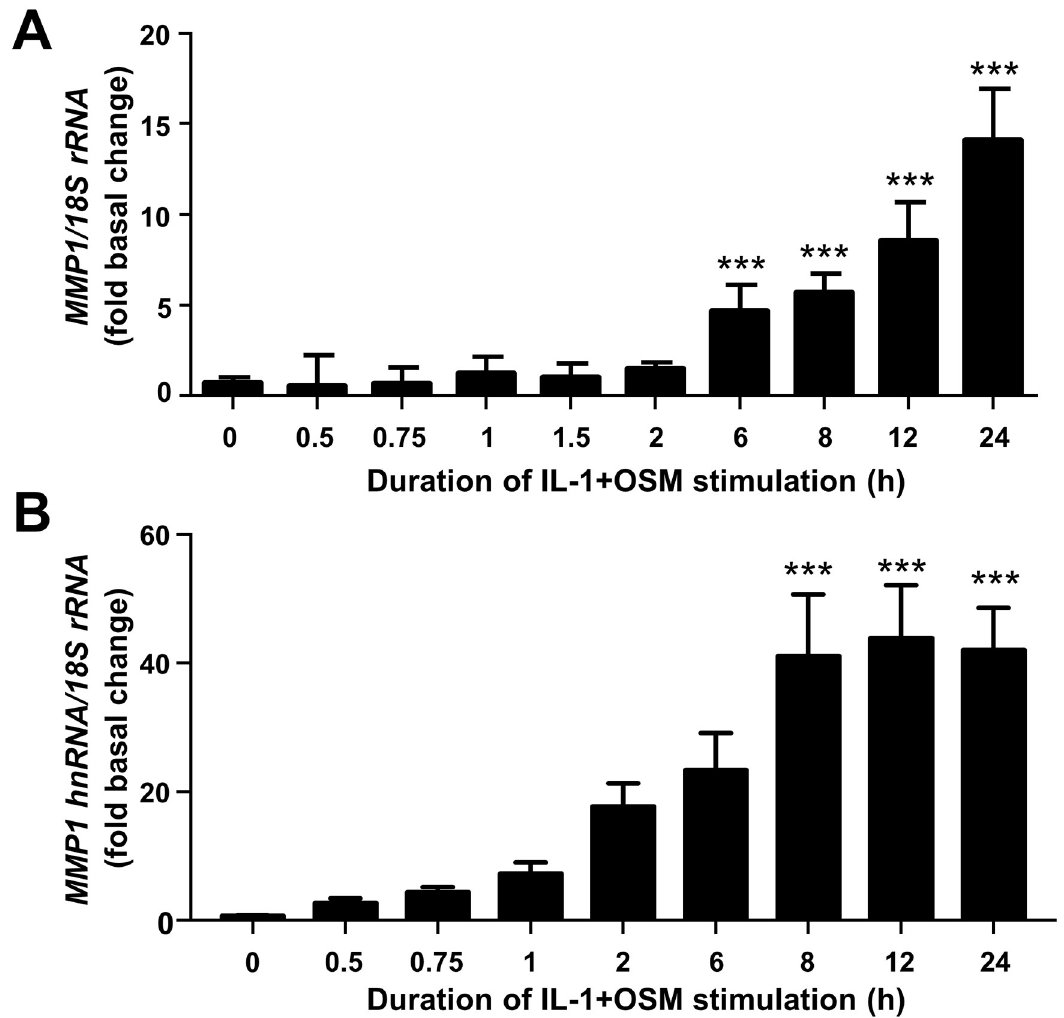
Fig 1. IL-1+OSM-induced MMP1 mRNA expression is preceded by nascent hnRNA formation. Chondrocytes were stimulated with IL-1 (0.05 ng/mL) in combination with OSM (10 ng/mL) for the indicated durations. Total RNA was isolated, reverse transcribed and subjected to qPCR for (A) MMP1 mRNA or (B) MMP1 nascent hnRNA as described in the Materials and Methods. Data are expressed relative to 18S rRNA and presented as fold increase compared to basal expression. qPCR data (n = 4) are representative of at least three separate chondrocyte populations. All data are presented as mean ( ± SD), where ��� , p < 0.001; �� , p < 0.01; � , p < 0.05 IL-1+OSM-treated compared to control; ANOVA.